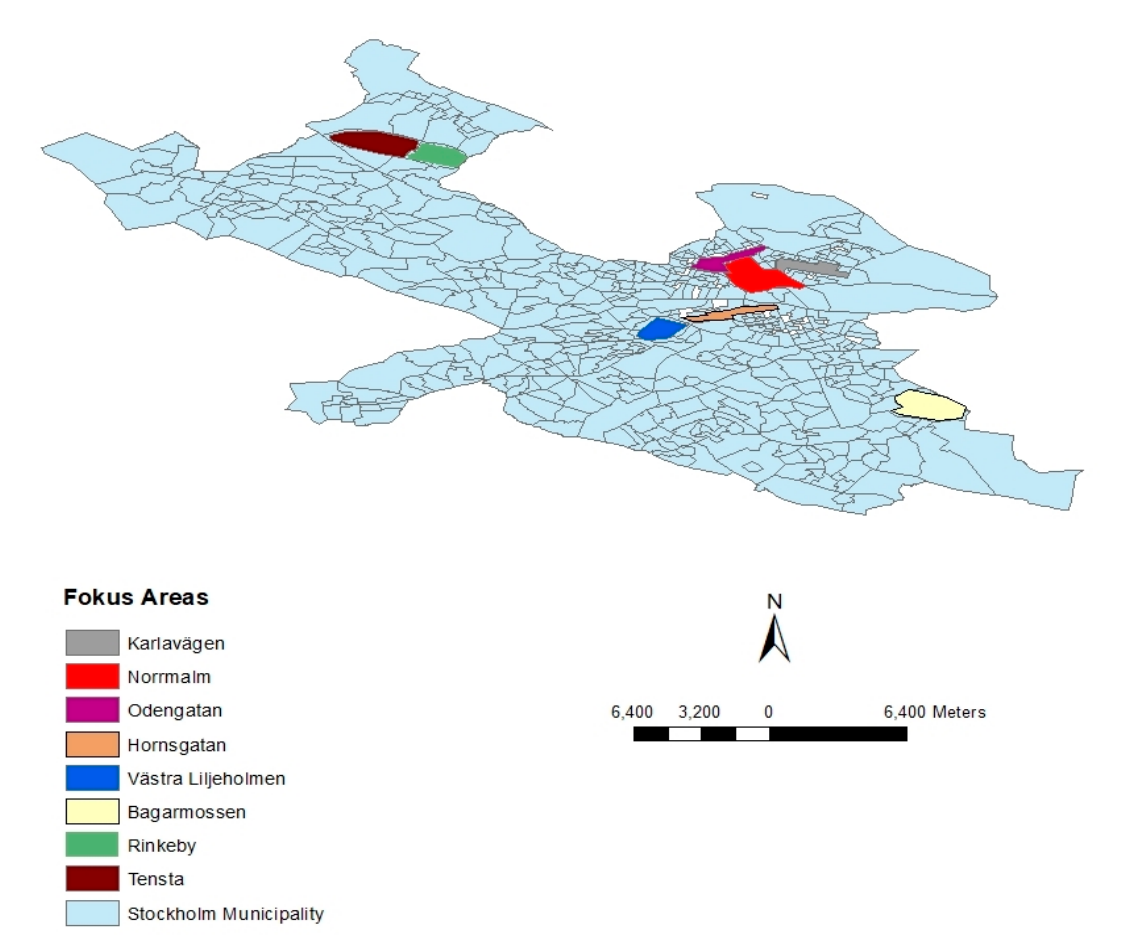
Figure 2. Focus areas in Stockholm